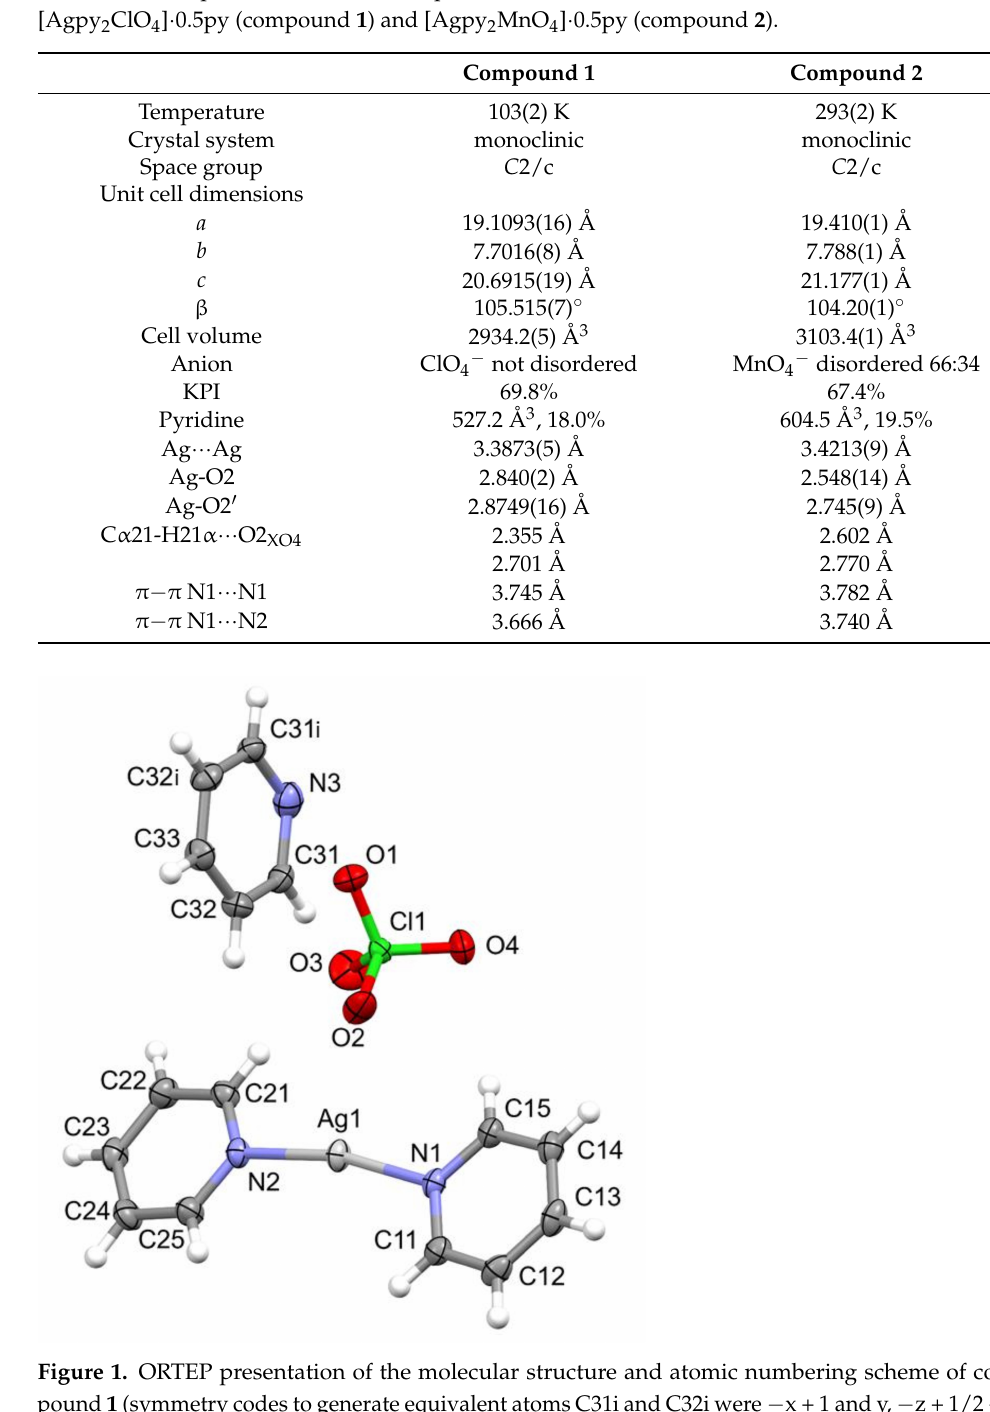
Table 1. Comparison of main cell parameters and inter- and intramolecular distances of